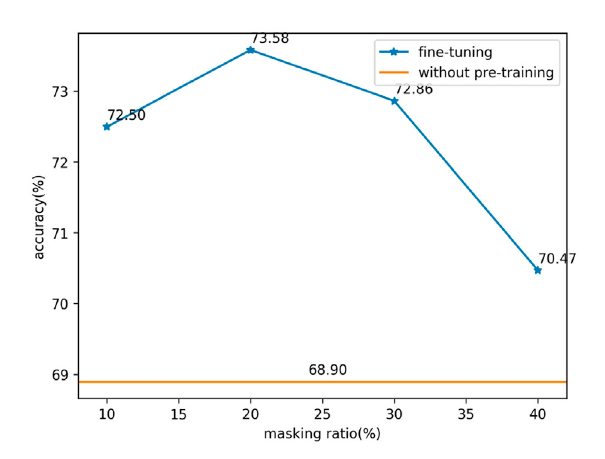
FIGURE 9 Comparing the accuracy of different masking ratios and non-pre-